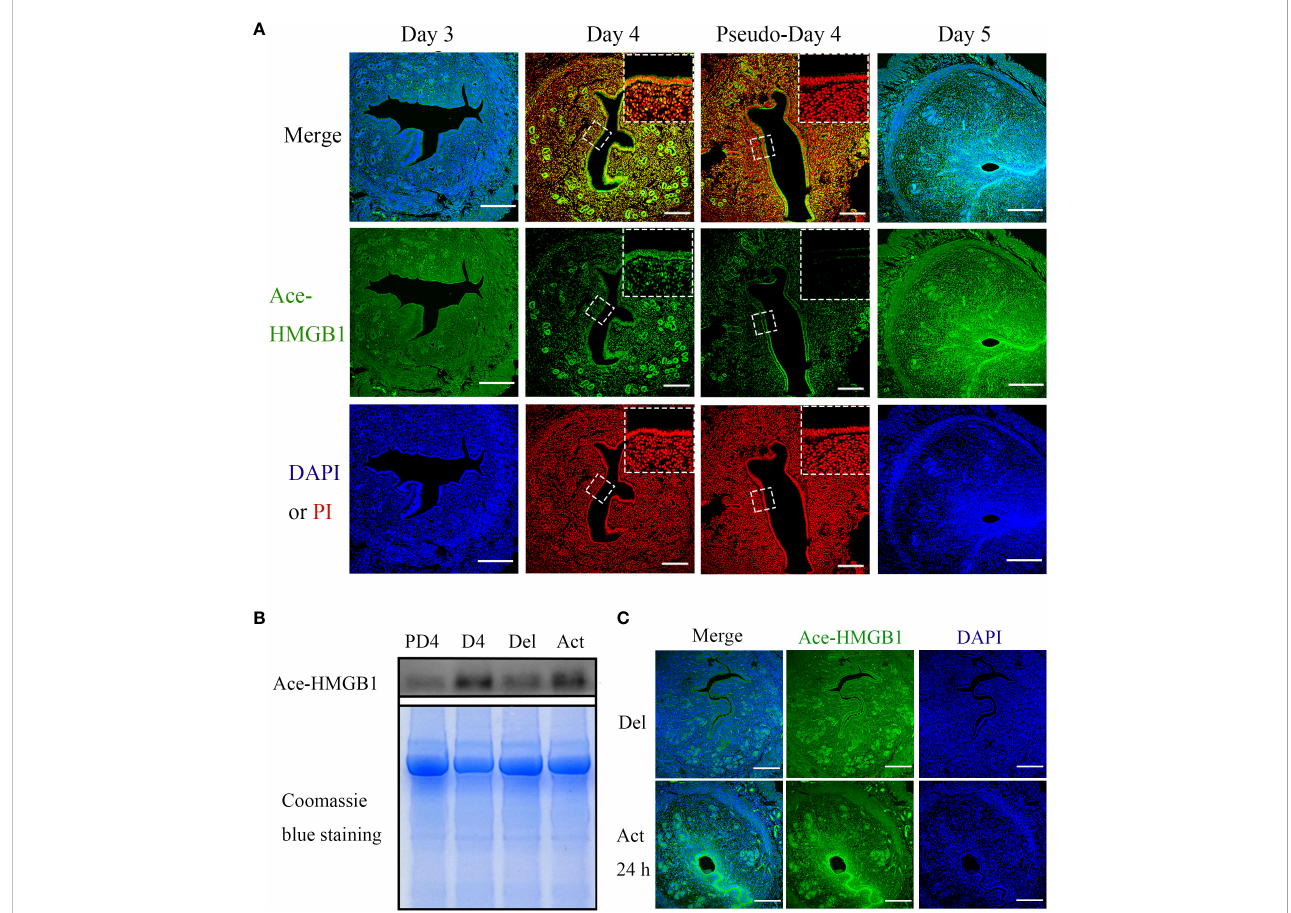
FIGURE 1 The immuno fl uorescence and protein levels of Ace-HMGB1 in mouse uterus during early pregnancy. (A) Acetylated HMGB1 immuno fl uorescence in mouse uteri on days 3, 4 and 5 of pregnancy, and on day 4 of pseudopregnancy. Scale bar=250 m m. (B) The protein levels of acetylated HMGB1 in uterine fl uid collected on day 4 of pregnancy and day 4 of pseudopregnancy, and in uterine lumen fl uid collected from mouse uterus under delayed implantation and 12 h after estrogen activation. The Coomassie blue staining of uterine fl uid was served as a loading control. (C) The acetylated HMGB1 immuno fl uorescence in mouse uterus under delayed implantation and estrogen activation. Scale bar=250 m